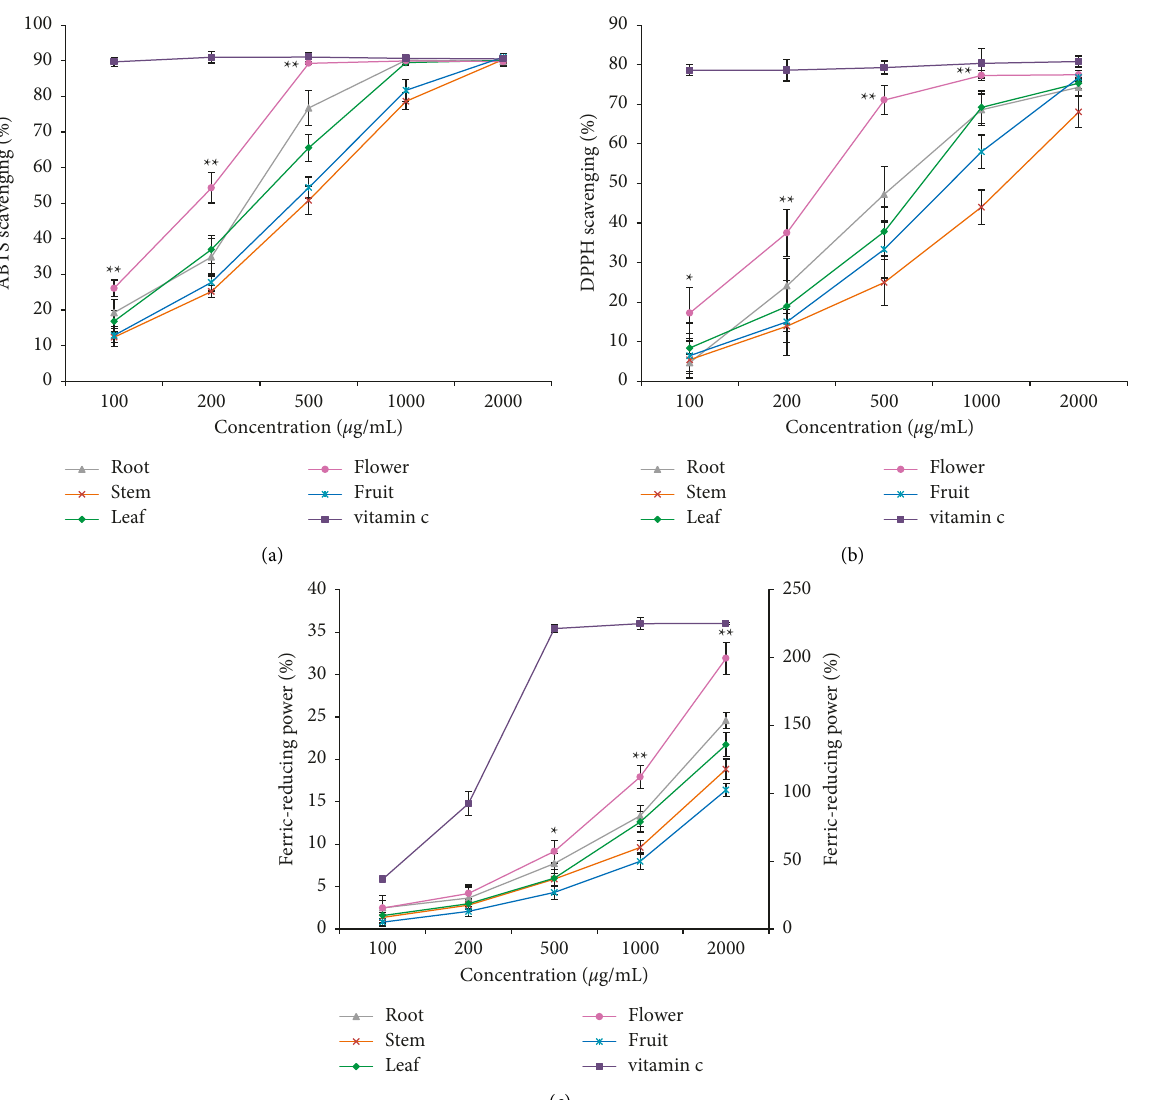
Figure 1: Comparison of antioxidant activities among the extracts from root, stem, leaf, flower, and fruit of D. nobile . (a) ABTS scavenging rate under different concentration of extracts. (b) DPPH scavenging rate under different concentration of extracts. (c) Ferric-reducing power under different concentration of extracts. Vitamin C was used as a positive control. ∗ indicates p < 0 . 05, ∗∗ indicates p < 0 . 01, when compared flower to root, stem, leaf, or